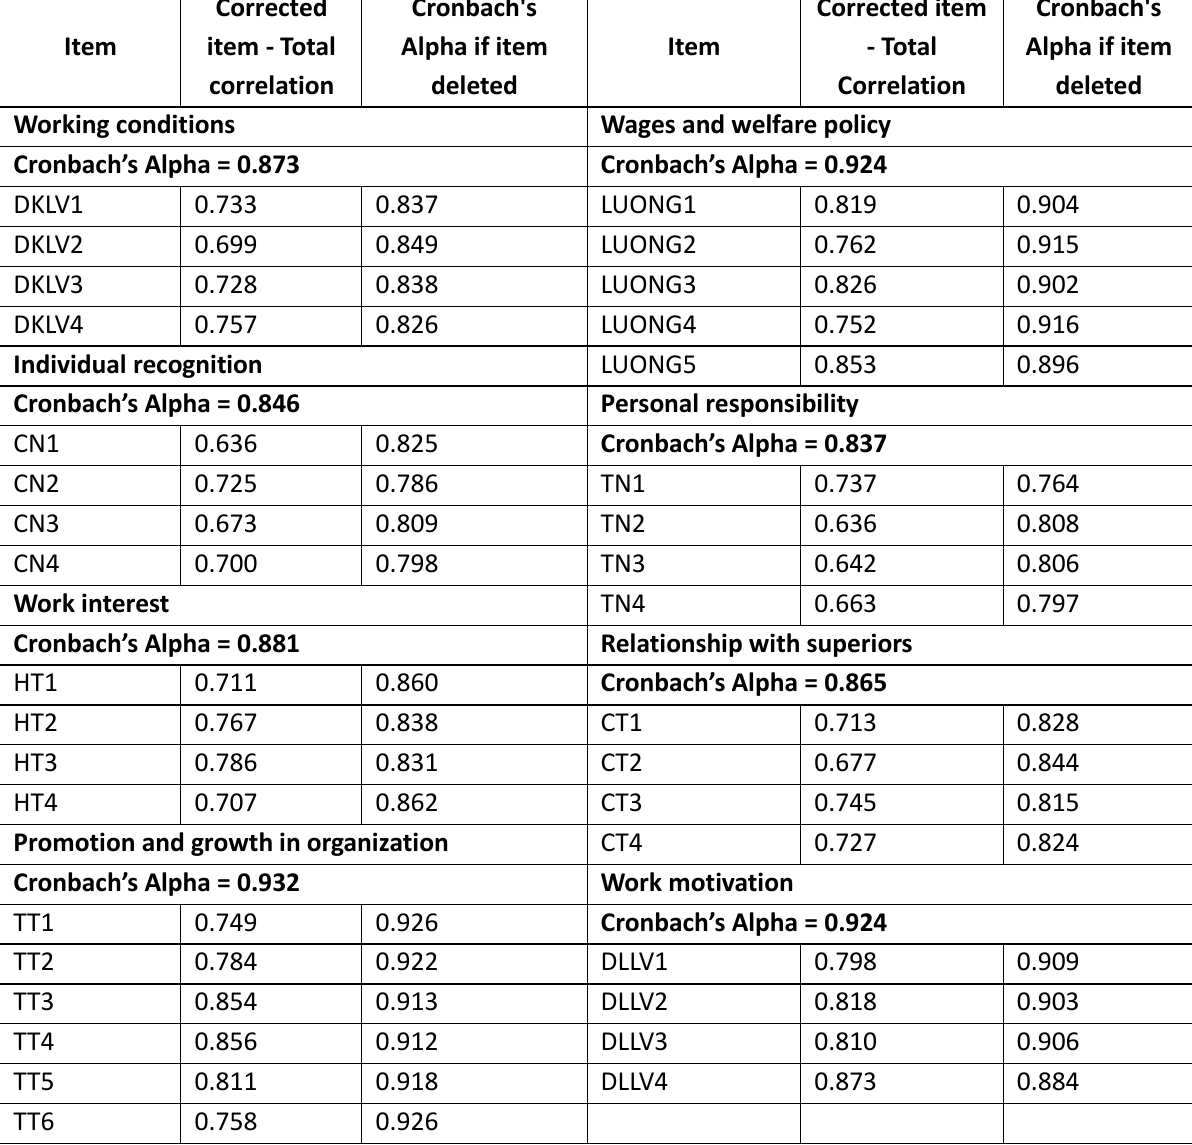
Table 2. Cronbach’s Alpha coefficient